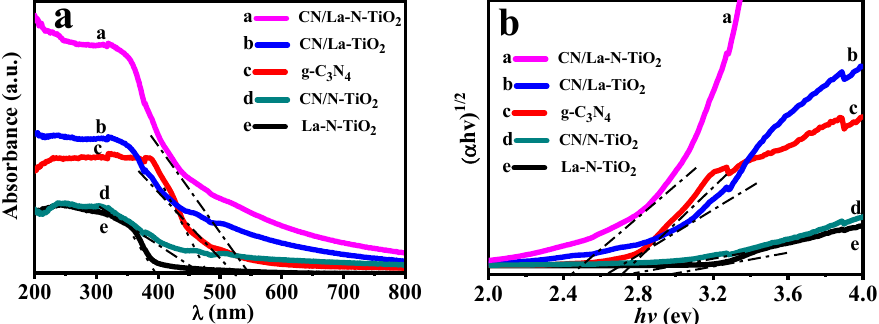
Figure 6. UV-vis spectra ( a ) of g-C 3 N 4 La-N-TiO 2 , CN/N-TiO 2 , CN/La-TiO 2 , and CN/La-N-TiO 2 composites, and ( b ) a plot of ( α h υ ) 1/2 versus the photon energy (h υ ).